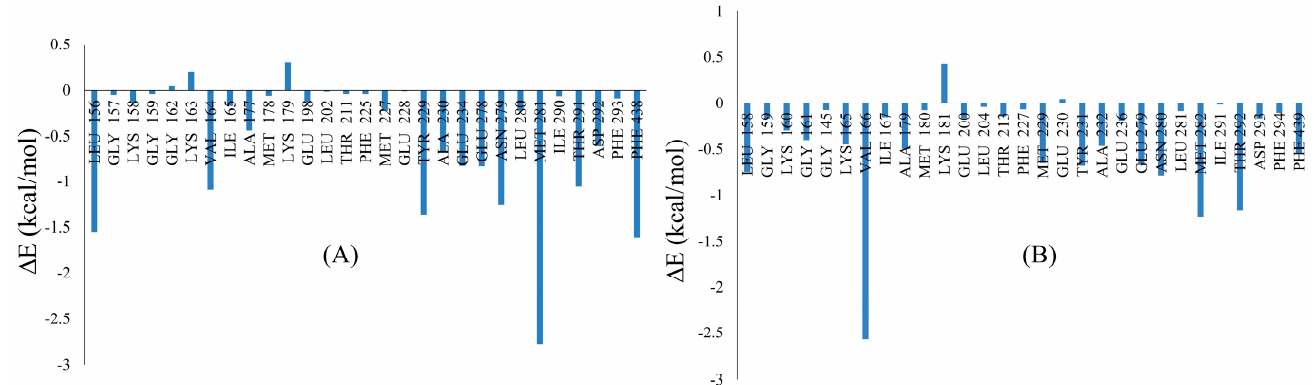
Figure 5. Total energy obtained from per ‐ residue decomposition analysis of Asn0019 in ( A ) AKT1 and ( B ) AKT2 enzymes .